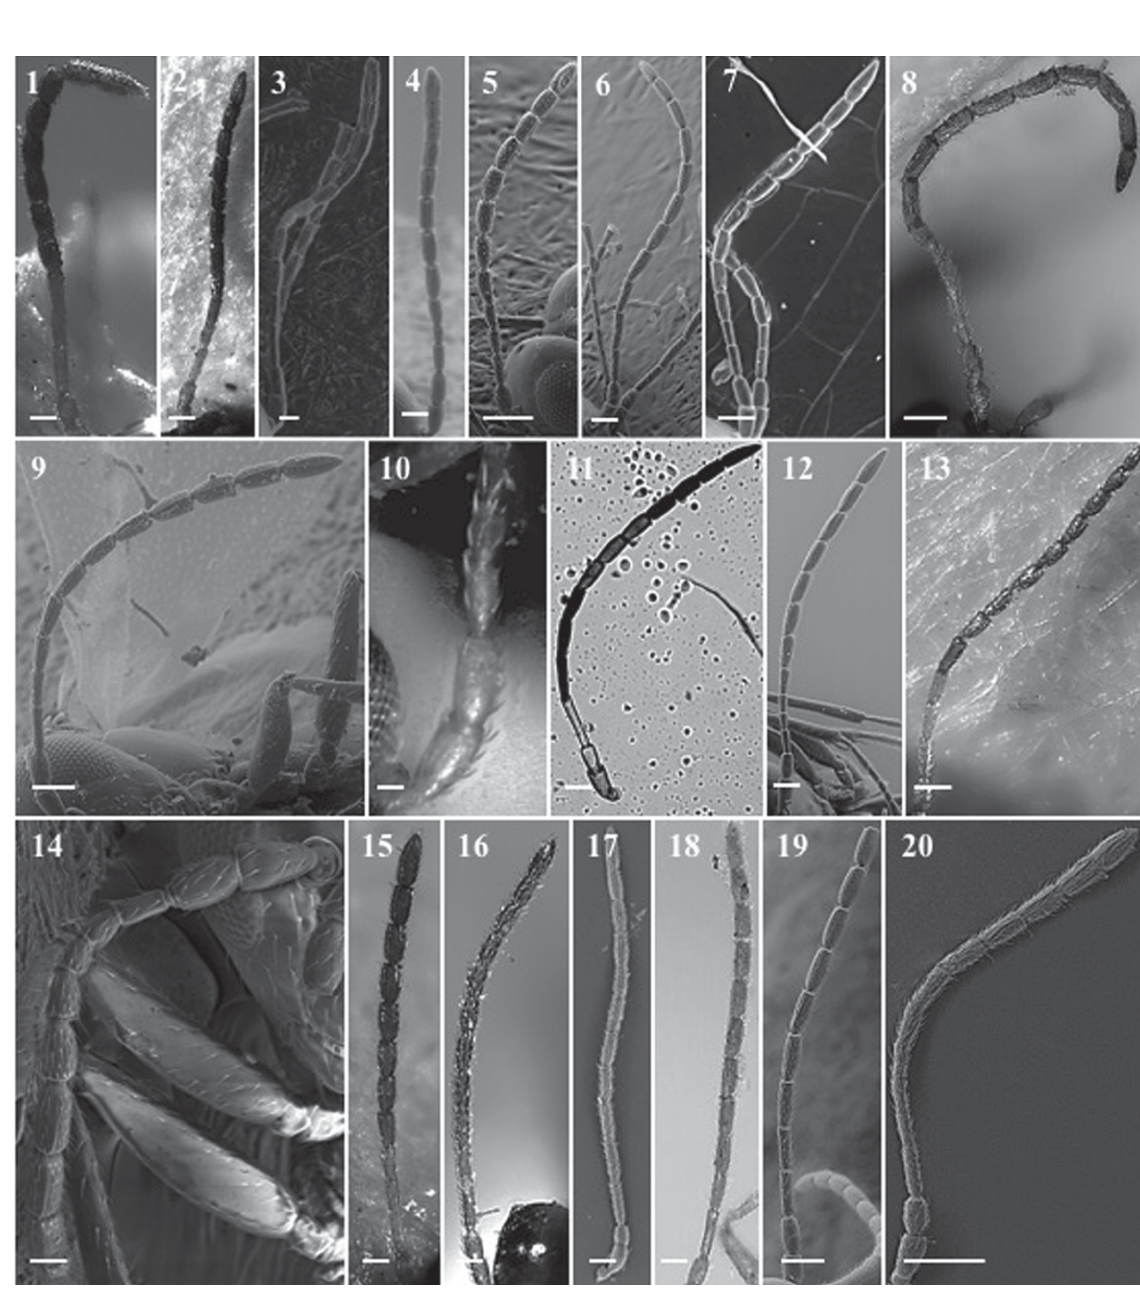
Fig. 3. Types of antenna of Alloxysta Förster, 1869. 1 . A. pedestris (Curtis, 1838). 2 . A. piceomaculata (Cameron, 1883). 3 . A. pilipennis (Hartig, 1840). 4 . A. pleuralis (Cameron, 1879). 5 . A. postica (Hartig, 1841). 6 . A. proxima Belizin, 1962. 7 . A. pusilla (Kieffer, 1902). 8 . A. quedenfeldti (Kieffer,